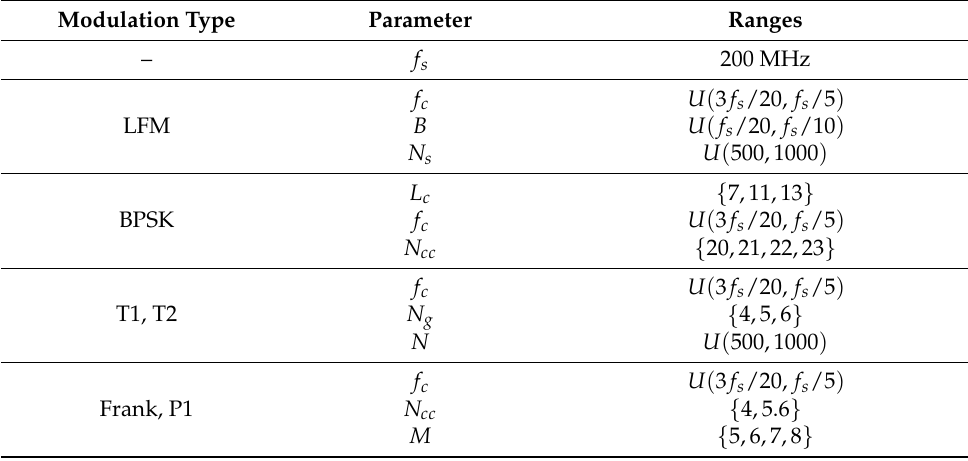
Table 2. The parameter settings of nine types of radar intra–pulse